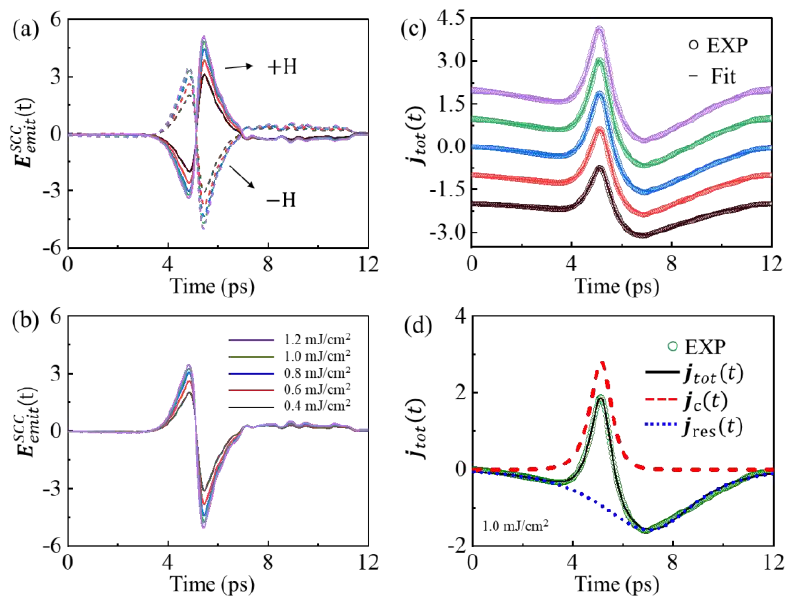
( t ) for opposite applied magnetic EOS EOSSCC (𝑡,+𝑴)−𝑬 EOSSCC (𝑡,−𝑴) ( t ) = E SCC EOS ( t , + M ) − E SCC EOS ( t , − M ) odd in M . ( c ) odd in emit 2 2 ( t ) (vertical offset for clarity). The solid lines are tot